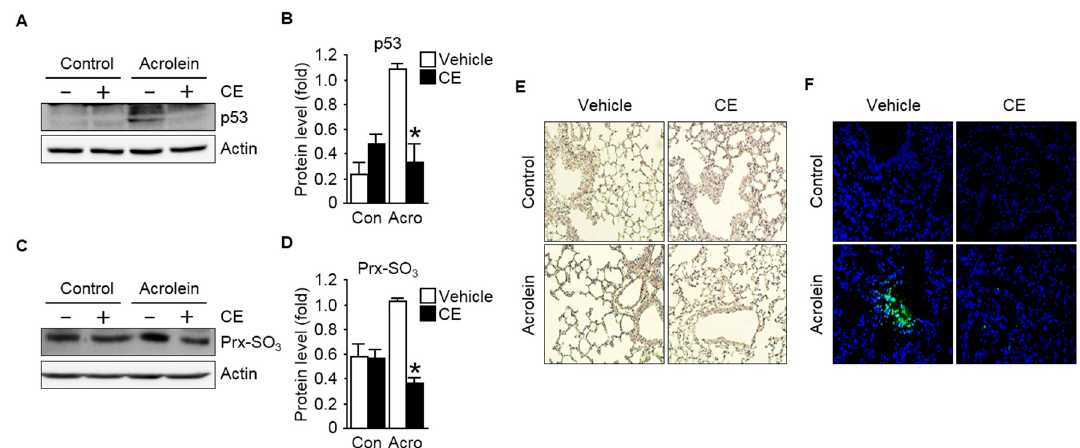
Figure5. E ff ectofCEonp53activationinpulmonarytissuesexposedtoacrolein: ( A )p53levelinthelung sections was determined by immunoblot analysis. Actin served as an internal control; ( B ) quantification of p53 levels normalized to the expression of actin is shown; ( C ) immunoblot analysis of Prx-SO 3 level, a marker for intracellular reactive oxygen species (ROS) formation, in acrolein-exposed lung tissues with or without pre-treatment with CE. Actin was used as the loading control; ( D ) a graph depicting the quantification of the relative abundance of the Prx-SO 3 protein levels is shown. Each protein sample was subjected to 8–12% SDS-PAGE and immunoblotted with related antibodies as described in the text; ( E ) representative histochemical staining of the lung tissues (20 × magnification) with 3,3 (cid:48) -diaminobenzidine (DAB) for the measurement of the level of intracellular H 2 O 2 ; ( F ) representative images of immunohistochemical analyses of lipid peroxidation adducts, 4-hydroxynonenal (4-HNE) in the lung tissues (400 × magnification). Nuclei were counterstained with 4 (cid:48) ,6-diamino-2-phenylindole (DAPI). Results are expressed as the mean ± S.D. (n = 3–6 mice per group). p < 0.05 was considered statistically significant. * indicates statistical significance compared to the acrolein-treated